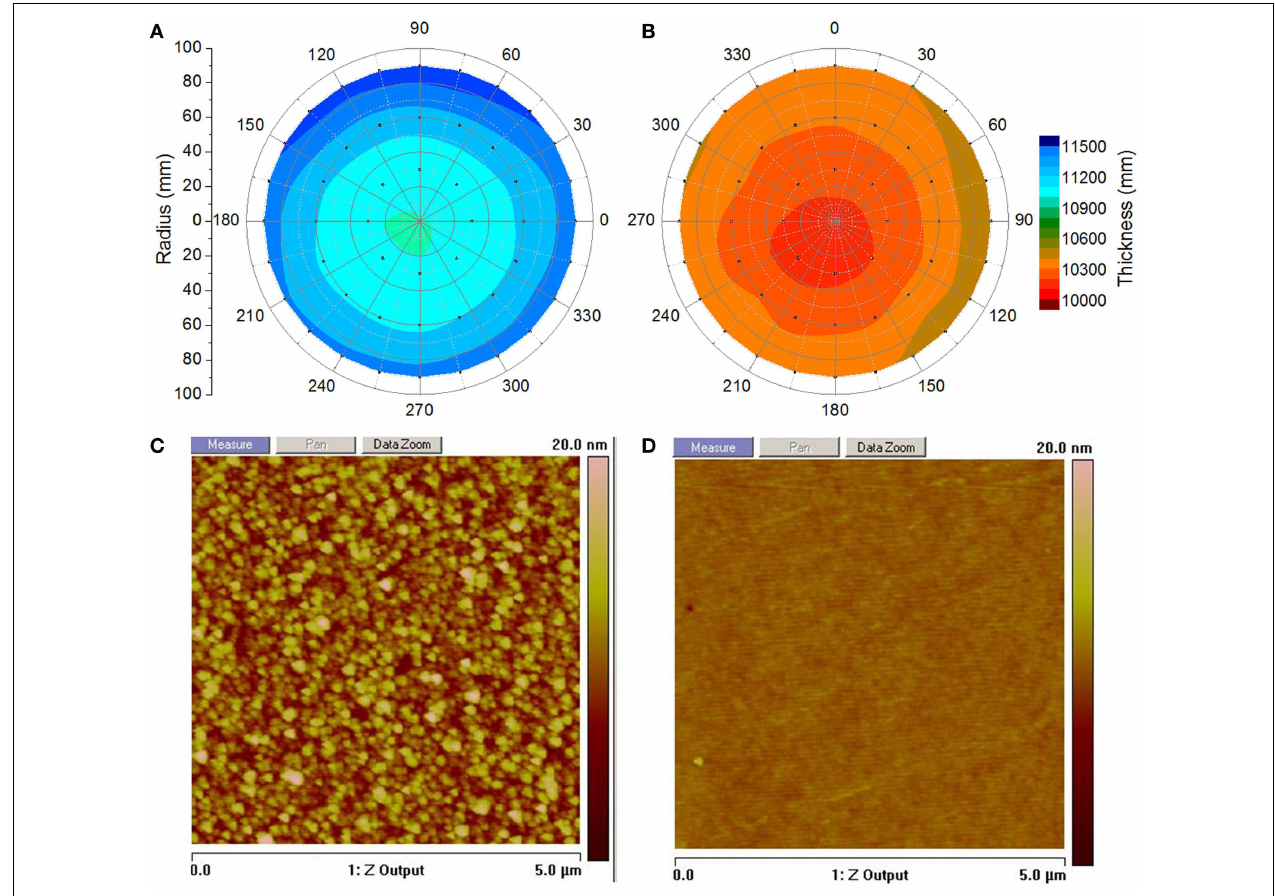
FIGURE 1 |The oxide thickness (A) before and (B) after CMP .The AFM results of the wafer surface roughness (C) before and (D) after CMP.